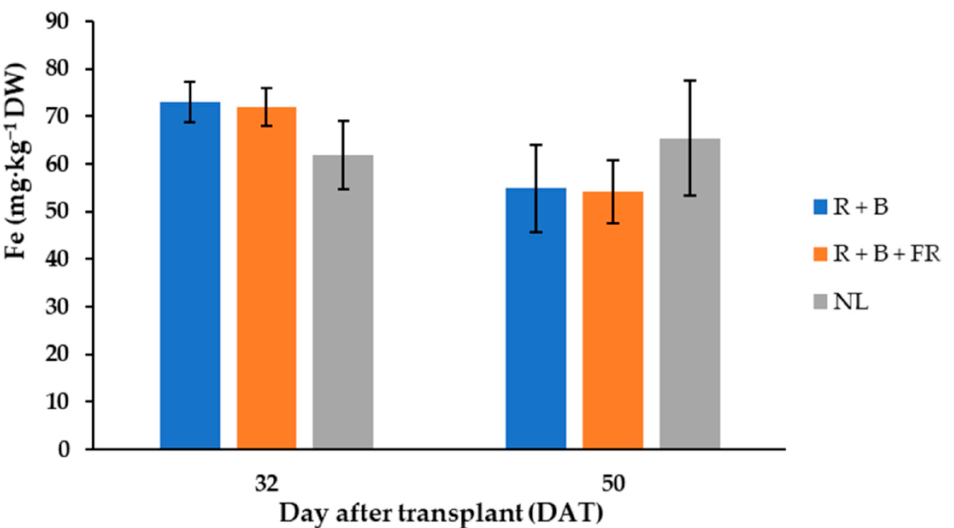
Figure 6. Iron (Fe) content, expressed as mg · kg − 1 D.W. of “Carosello leccese” ( Cucumis melo L.) fruits grown under solar light (NL, no supplementary lighting) and two light spectra (see Figure 1). Values are an average of three replications. Vertical bars represent mean values ± standard error. R + B represents supplementary light with red + blue spectra; R + B + FR represents supplementary light with red + blue + far red spectra; NL represents solar light (control) treatment.